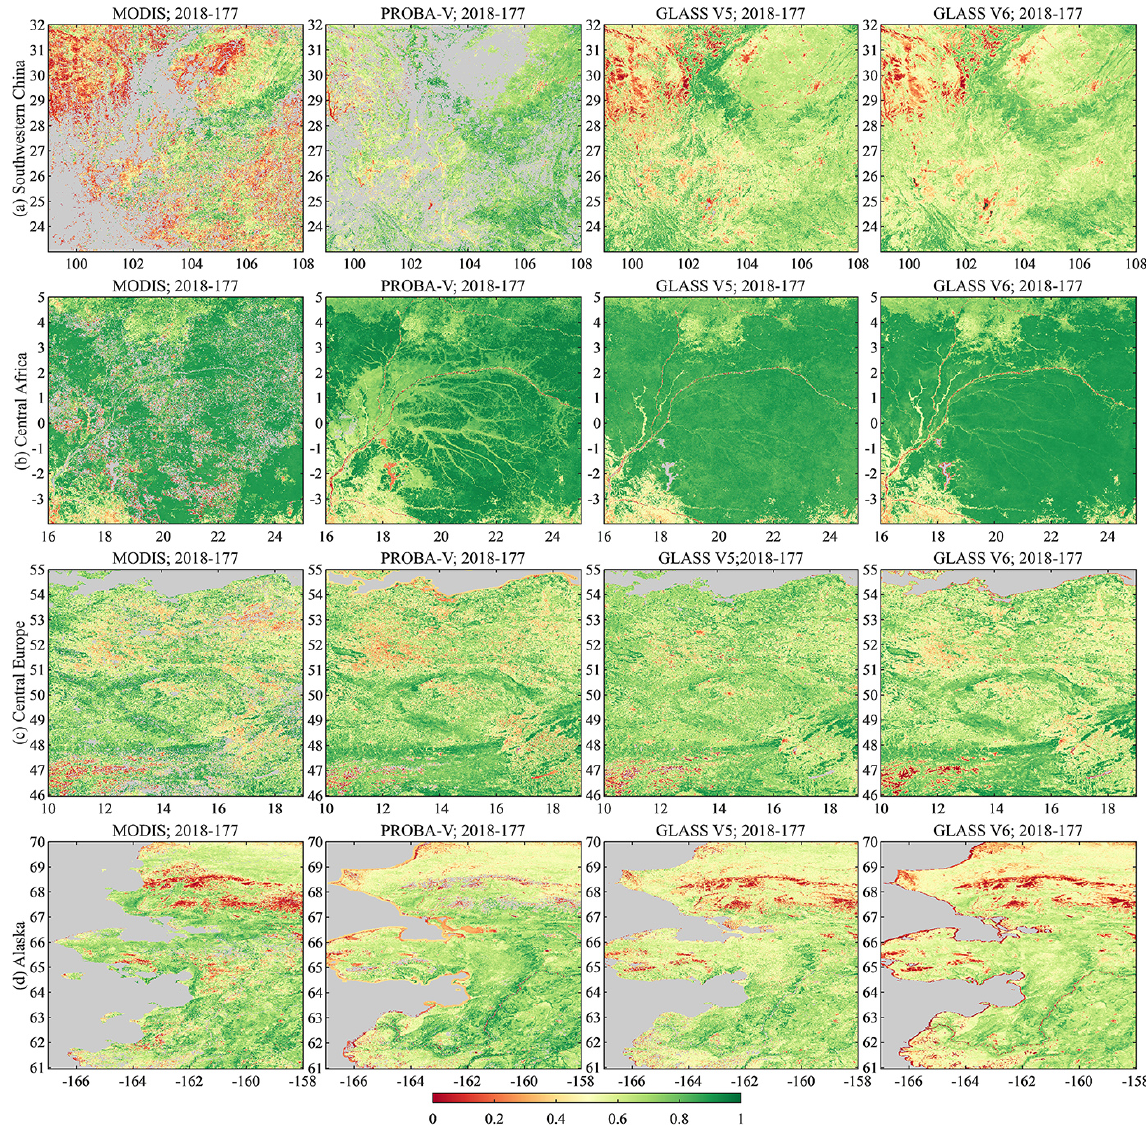
Figure 8. Spatial distribution of MODIS, PROB-V, GLASS V5, and V6 FAPARs on DOY 177 in 2018 in four regions: (a) the Yungui district in southwestern China; (b) the Congo Rainforest in central Africa; (c) central Europe; and (d) Alaska. The spatial resolution is 500m latitude and